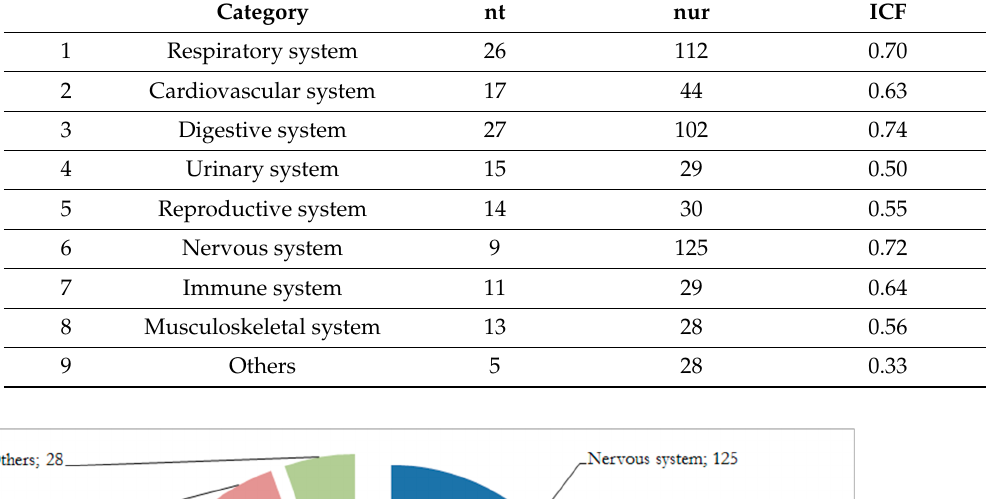
Table 2. ICF factor by diseases categories for Central Rhodopes.